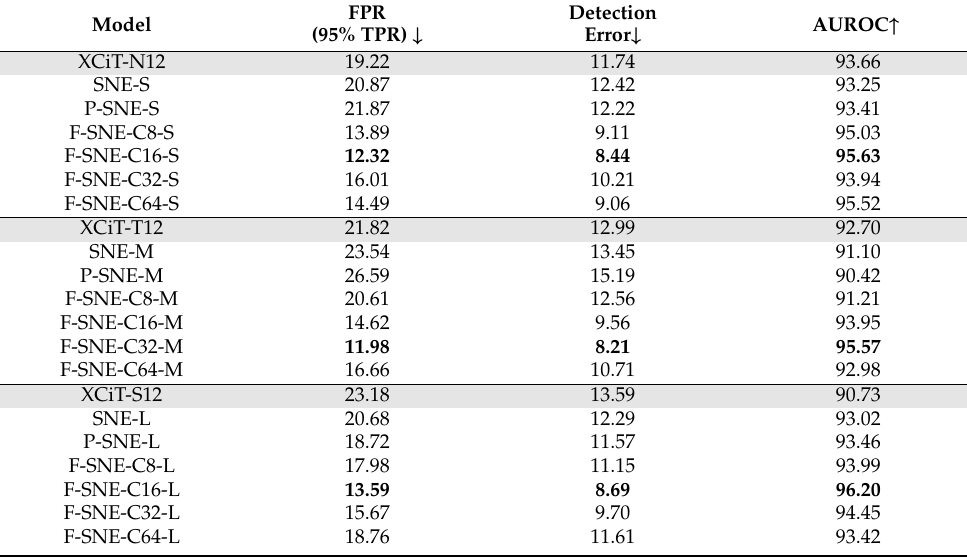
Table 7. Proposed models were evaluated on the OOD detection task as below. The models fine-tuned on CIFAR-10, mentioned in Table 6, were used. We considered CIFAR-10 as ID and LSUN-R, LSUN-C, iSUN, SVHN, and DTD as OOD. Scores are averaged for the OOD datasets.